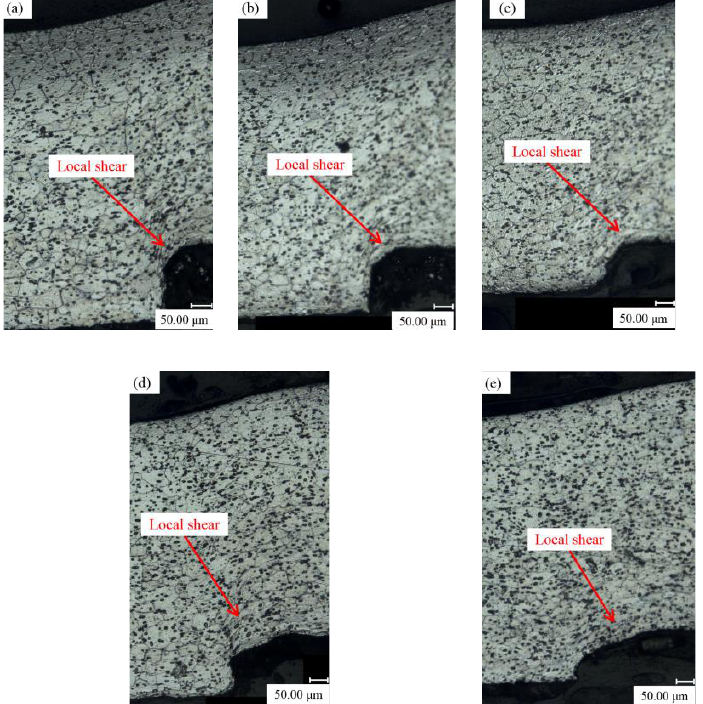
Figure 13. Metallographic structure of deformed area of pipe with different fillet radii. ( a ) No fillet. ( b ) Groove fillet radius 0.05 mm. ( c ) Groove fillet radius 0.1 mm. ( d ) Groove fillet radius 0.15 mm. ( e ) Groove fillet radius 0.2 mm.